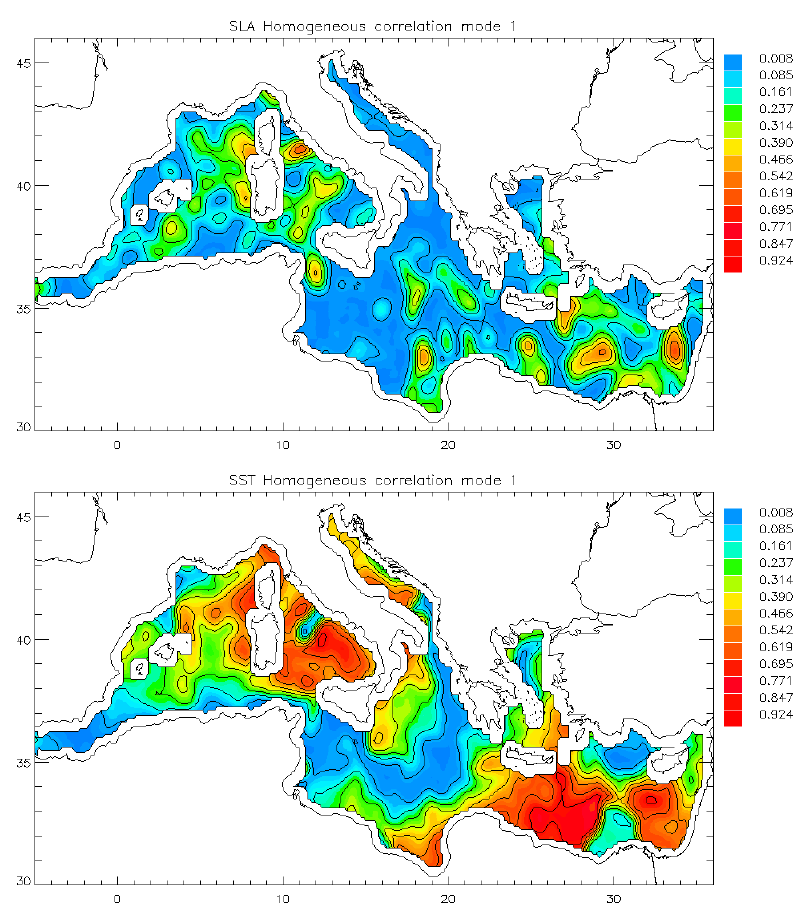
Fig. 6. SLA (a) and SSTA (b) homogeneous correlation maps relative to the first “gradient CPA” mode.